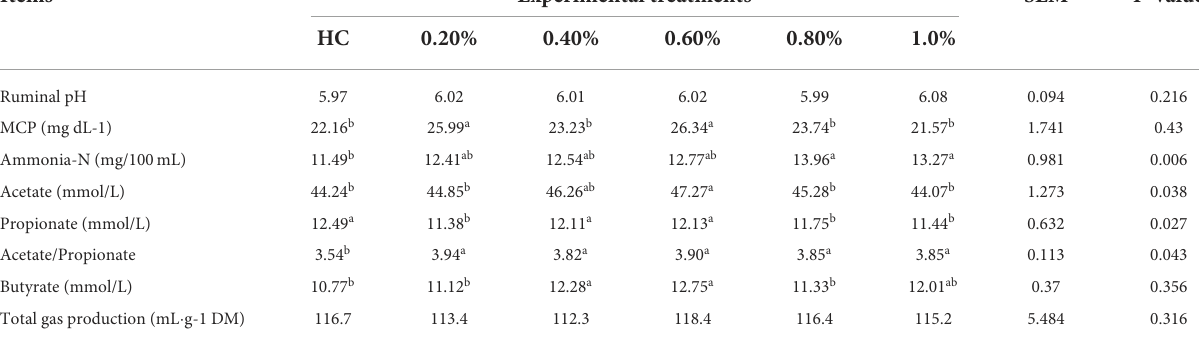
TABLE 2 Effects of small peptide supplement in high-concentrate diets on rumen fermentation parameters ( n , 6). Items